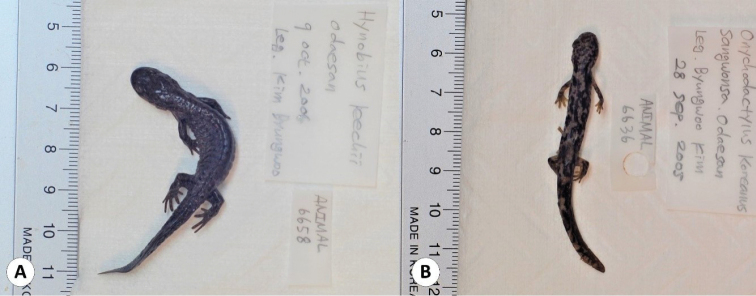
Some of the salamander specimens deposited in the collection of the EWNHMAHynobius
leechii (EWNHM-ANIMAL 6658) BOnychodactylus
koreanus (EWNHM-ANIMAL 6636).